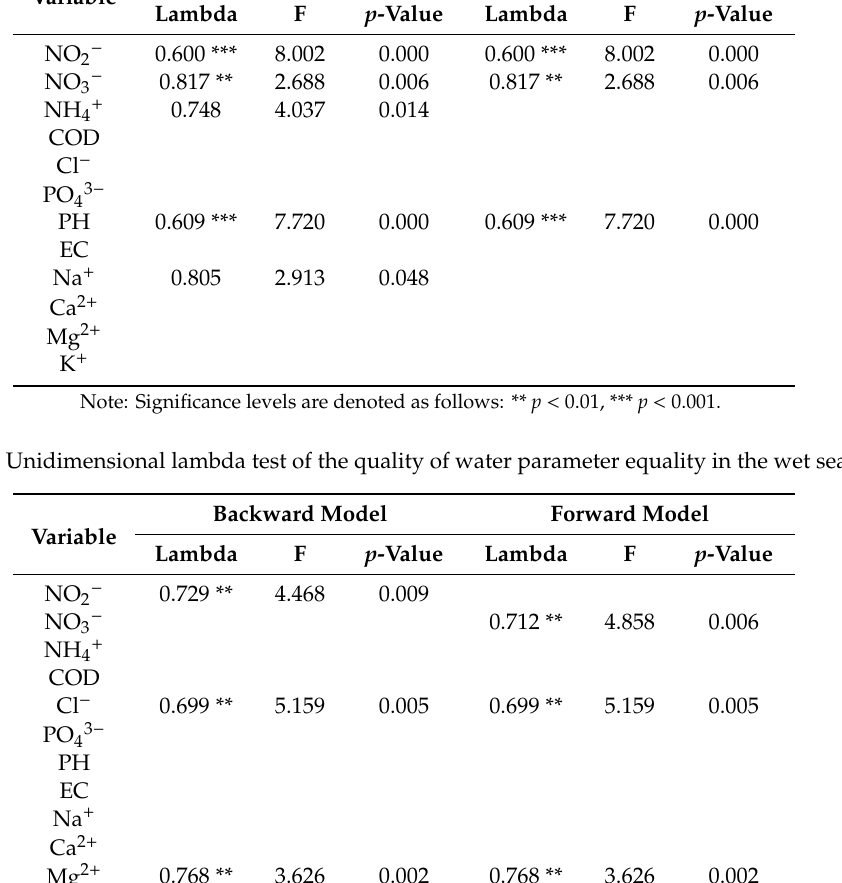
Table 4. Unidimensional lambda test of the quality of water parameter equality in the dry season. Backward Model Forward Model Variable Lambda F p -Value Lambda F p -Value NO 2 − 0.600 *** 8.002 0.000 0.600 *** NO 3 − 0.817 **